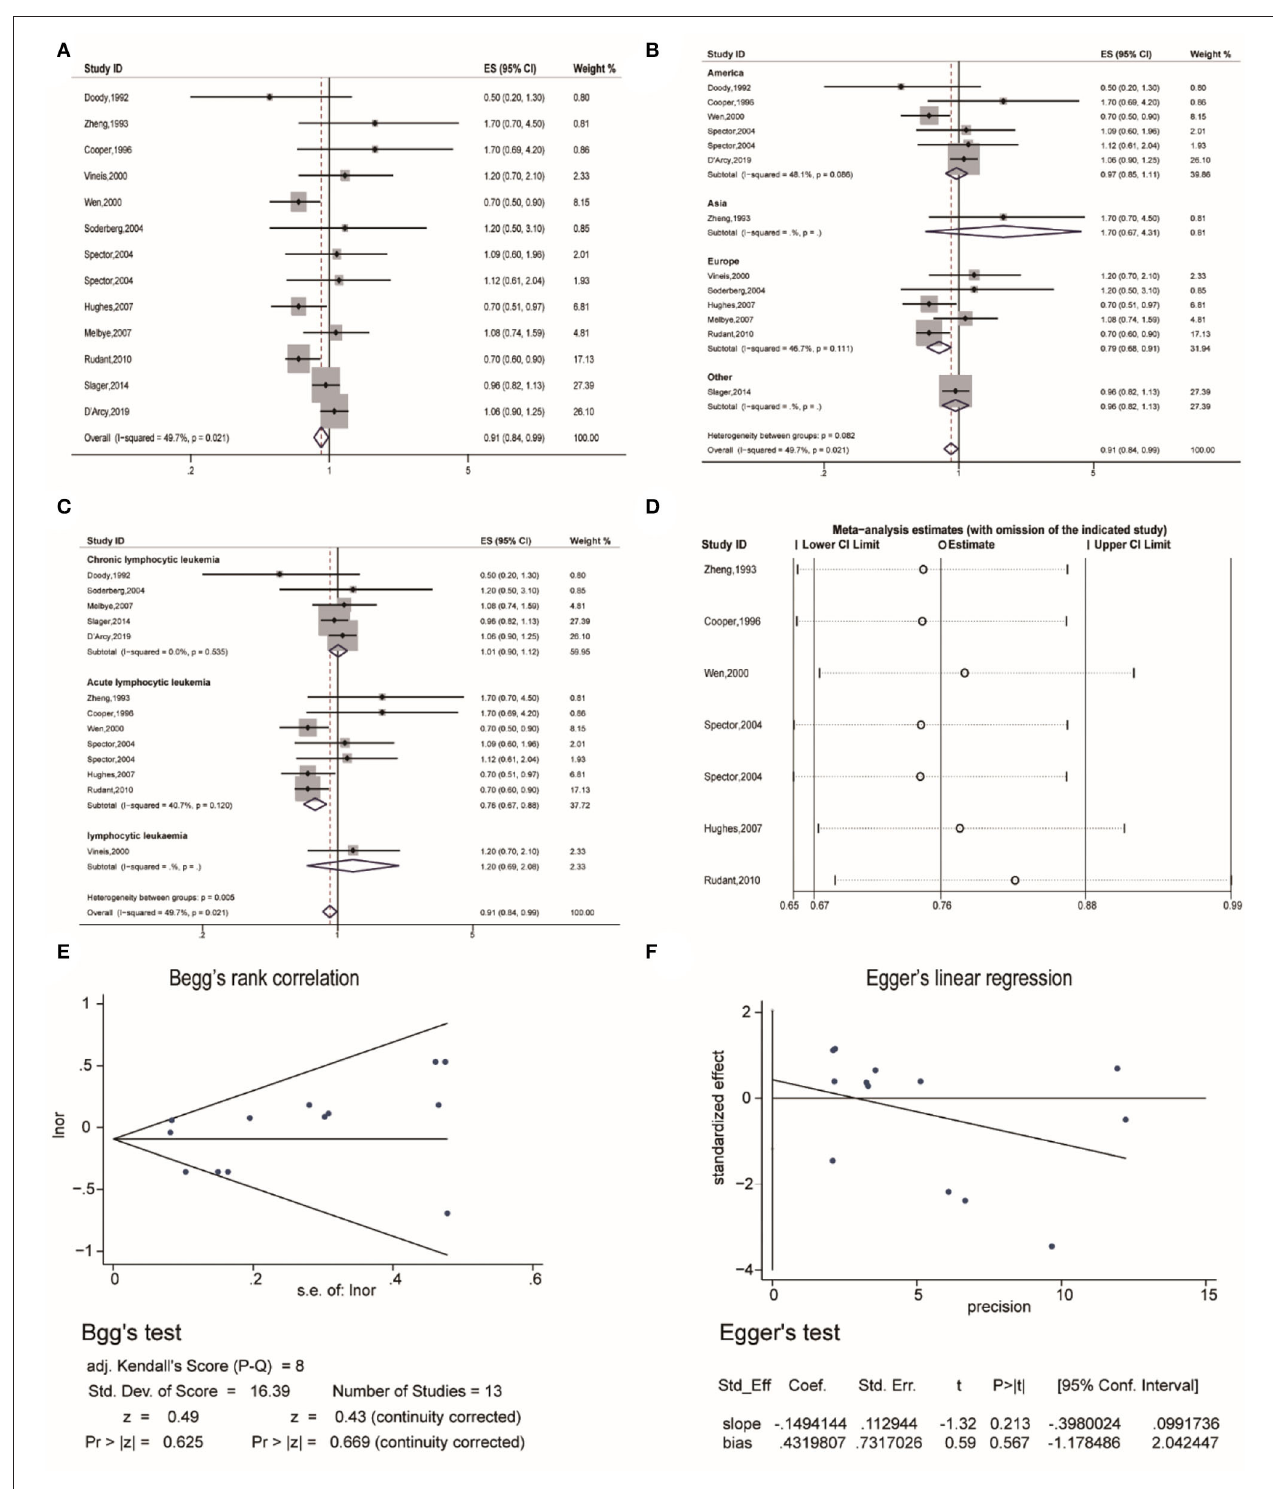
FIGURE 4 | The association between eczema and lymphocytic leukemia risk. (A) Forest plot of the estimated effects of eczema on lymphocytic leukemia risk. (B) Forest plot for the subgroup analysis by region. (C) Forest plot for the subgroup analysis by cancer type. (D) Sensitivity analysis regarding the association between eczema and acute lymphocytic leukemia risk. (E) Begg’s test indicating the lack of publication bias among such studies. (F) Egger’s test indicating the lack of publication bias among such studies.